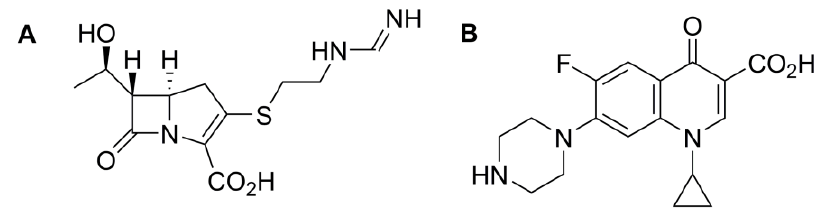
Figure 1. Chemical structure of ( A ) imipenem and ( B ) ciprofloxacin.